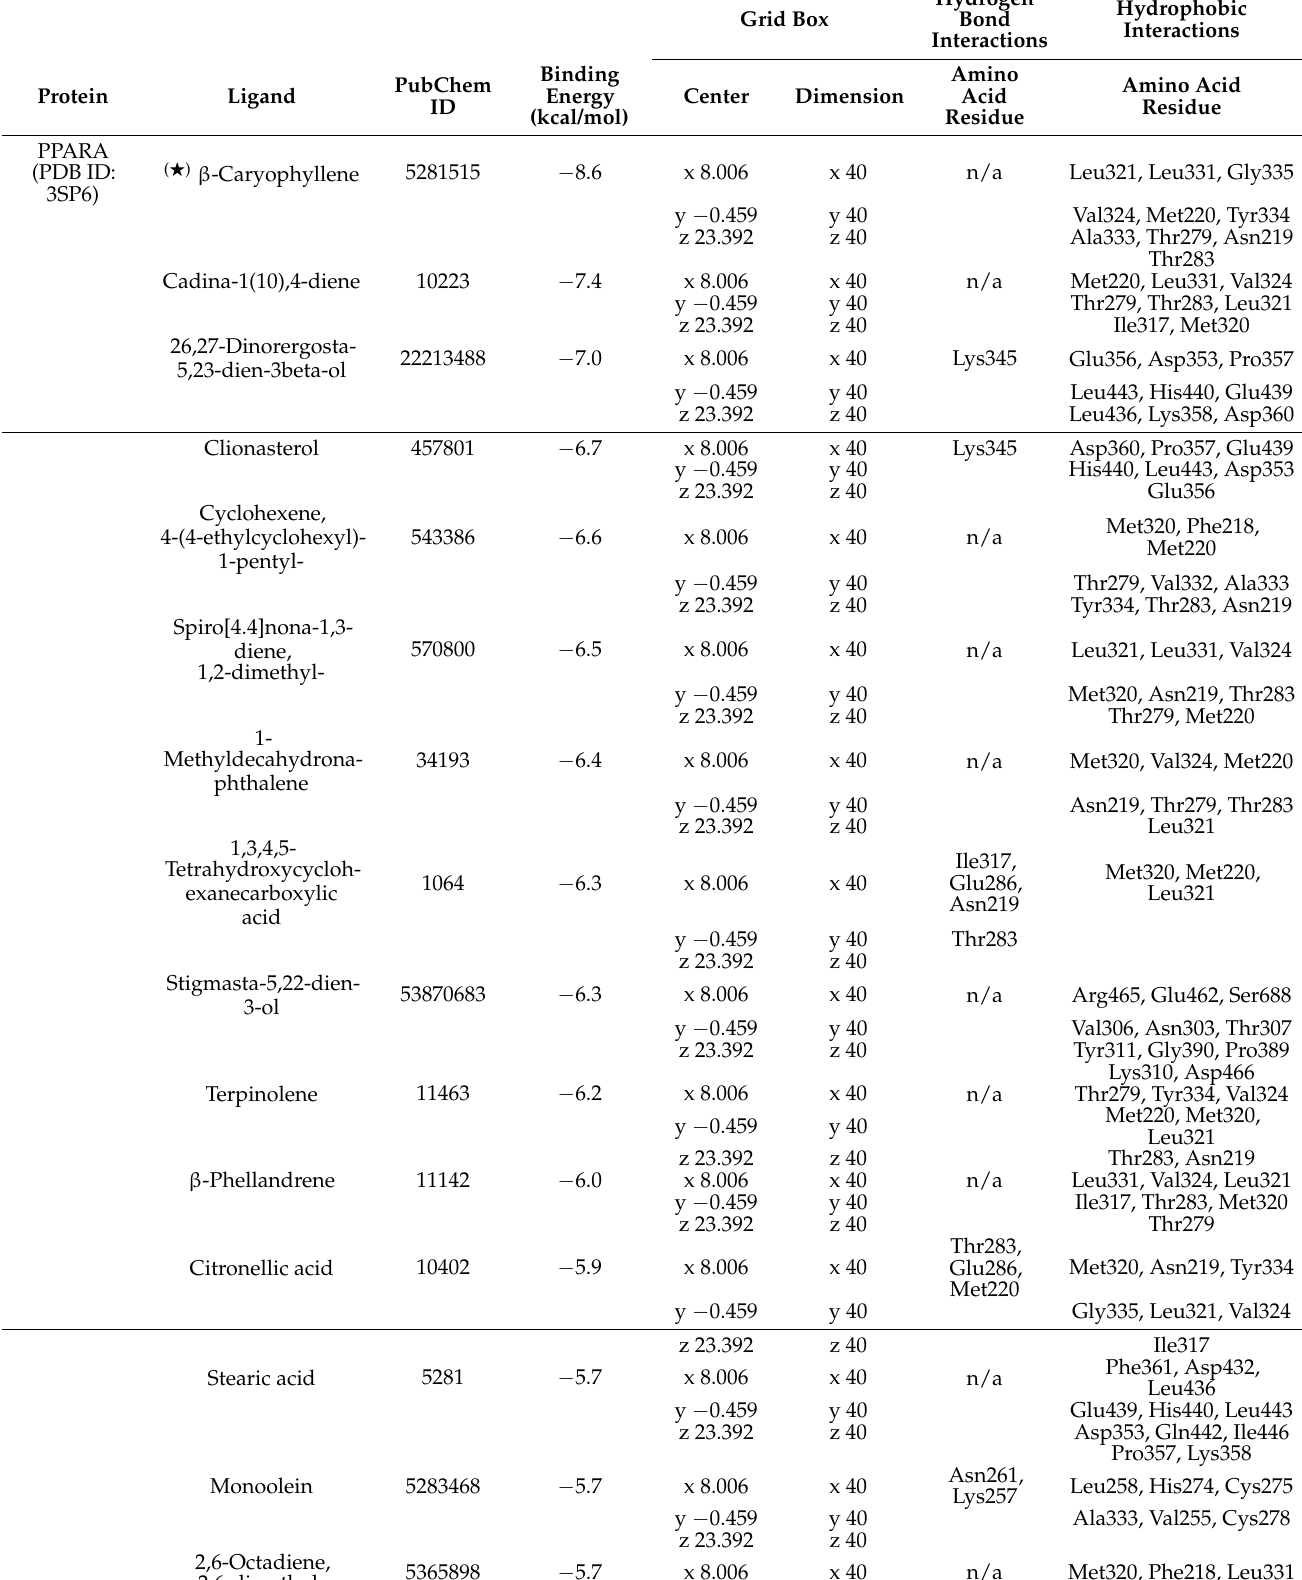
Table 7. Binding energy of ligands and positive controls on PPAR signaling